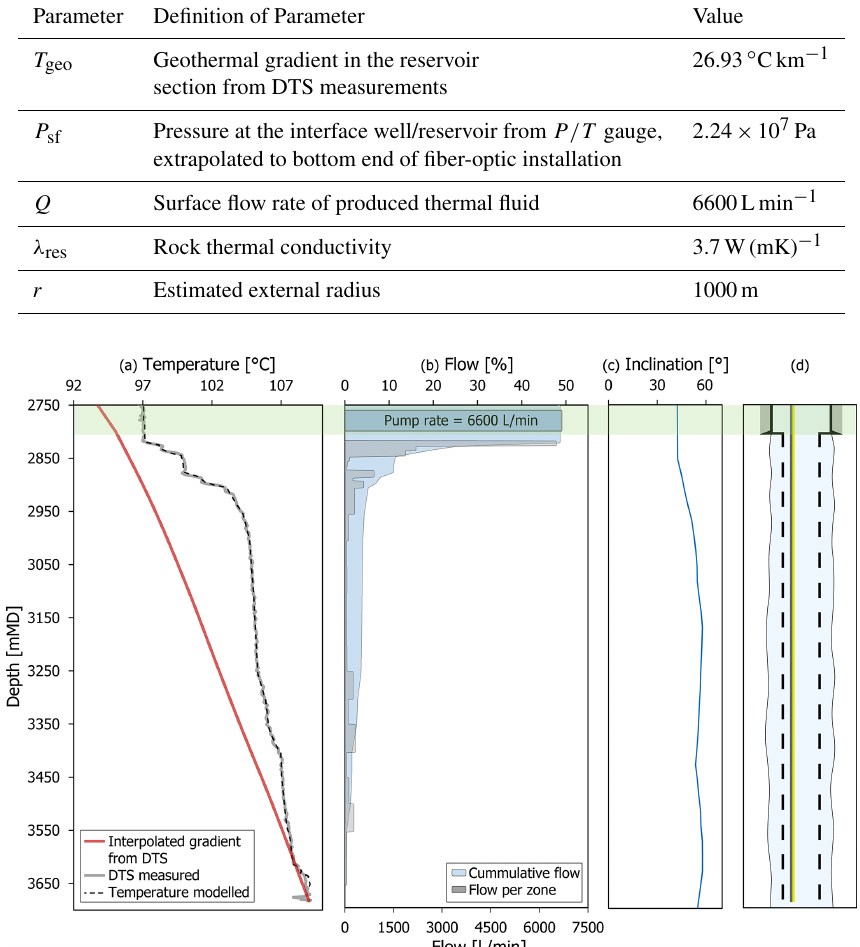
Figure 4. Results of DTS production profiling model inside the reservoir of SLS TH4. (a) Measured temperature (DTS, grey line) and modelled temperature (black dashed line) with estimated geothermal gradient (red line) versus depth, (b) modelled contribution of flow (grey) and cummulative flow in the bore (light blue) in comparison to surface pump rate (blue), (c) Inclination of the well, (d) well sketch of reservoir section. The olive band highlights the casing section. The shown results were generated with KAPPA Emeraude